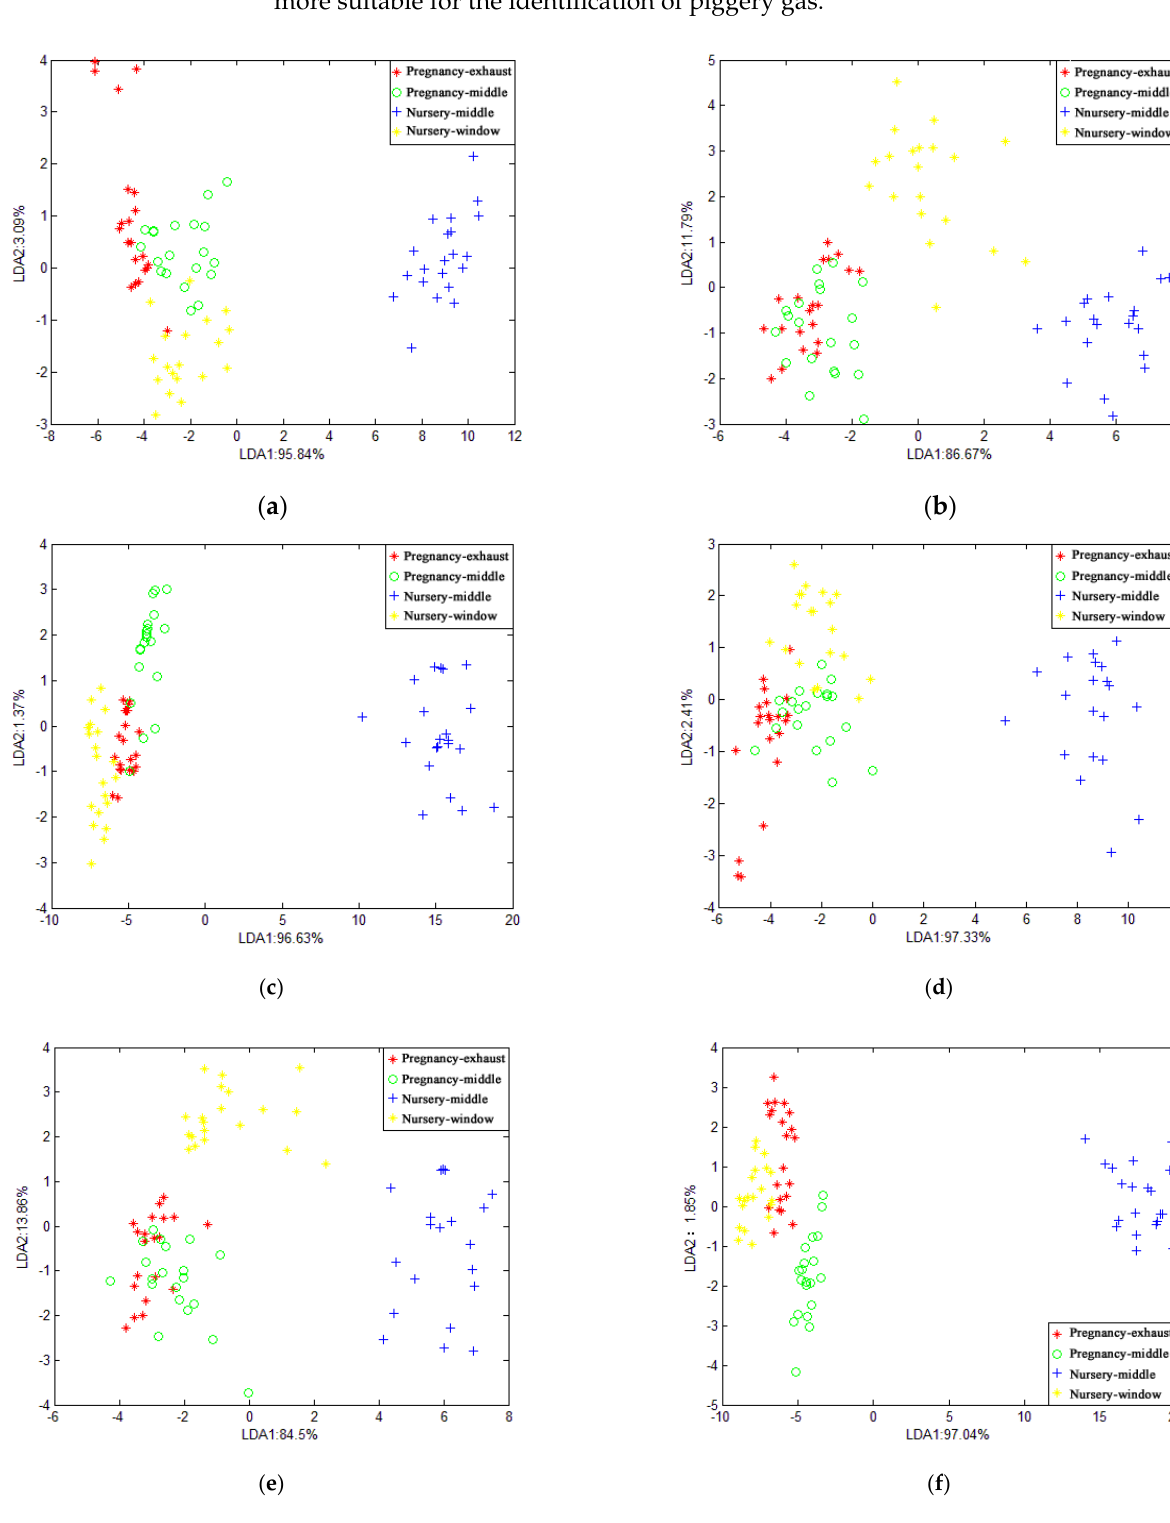
Figure 7. LDA chart of different positions at the same time in pig house: ( a ) morning when features are at average value; ( b ) afternoon when features are at average value; ( c ) evening when features are at average value; ( d ) morning when features are at maximum value; ( e ) afternoon when features are at maximum value; ( f ) evening when features are at maximum value.